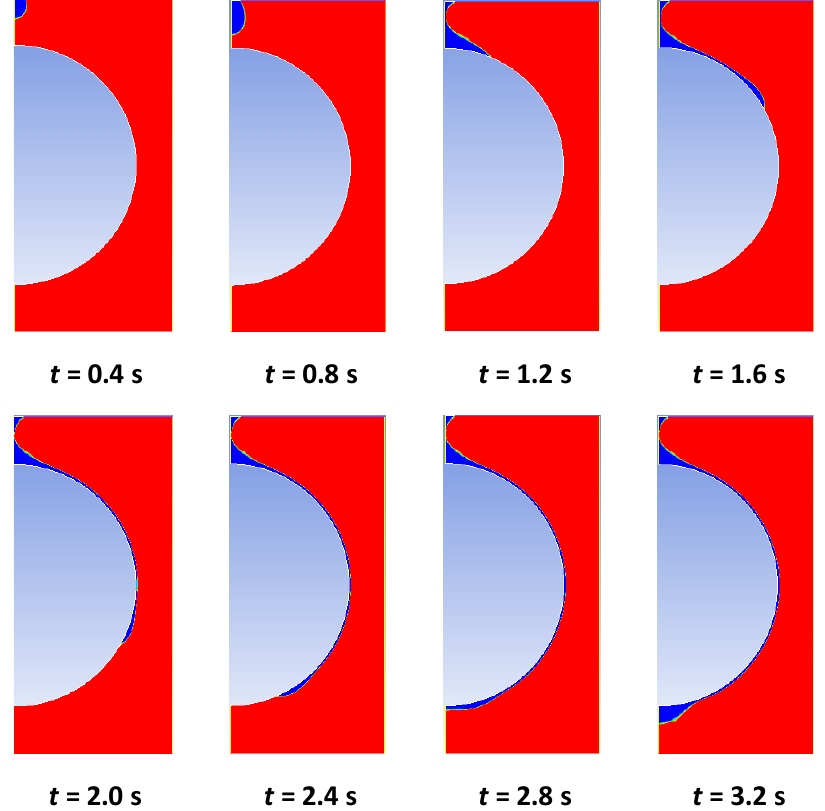
Figure 5. Volume fraction contours for Γ 1 / 2 = 0.01 kg/(m·s) and C = 0.65 w.r.t. time.